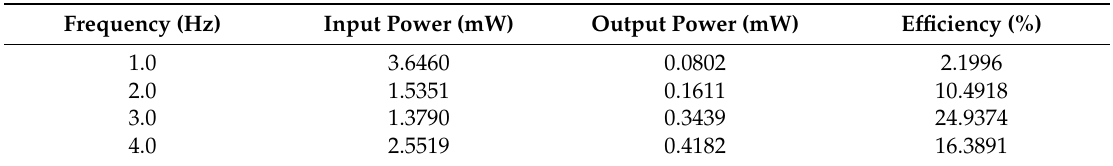
Figure 13. Average output power of charging different capacitors under hand clapping movements under different frequencies. Table 2. Average results of charging a 47 µF capacitor under hand clapping movements with different frequencies.